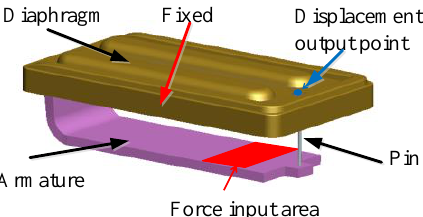
Figure 3. Mechanical simulation modeling.